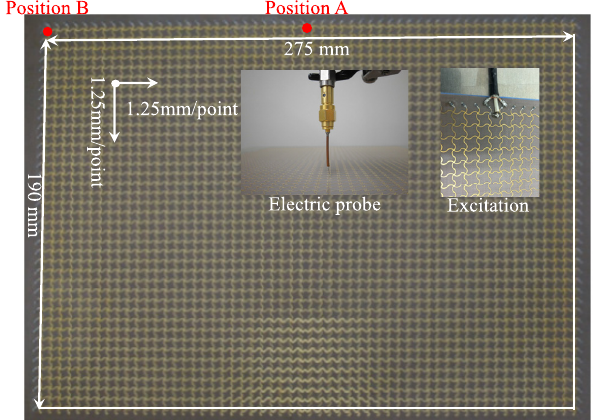
Fig. 19. Measured region. An excitation source is connected either at the position A or B. The total number of the measured points is 221 (cid:5)